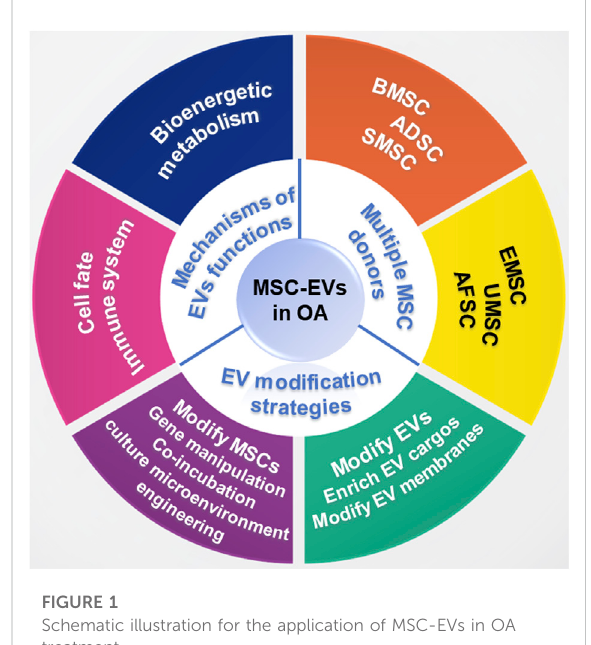
FIGURE 1 Schematic illustration for the application of MSC-EVs in OA